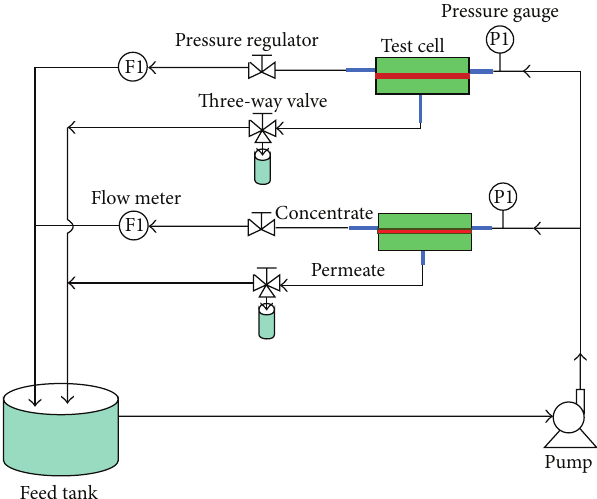
Figure 1: The cross-flow filtration unit in this